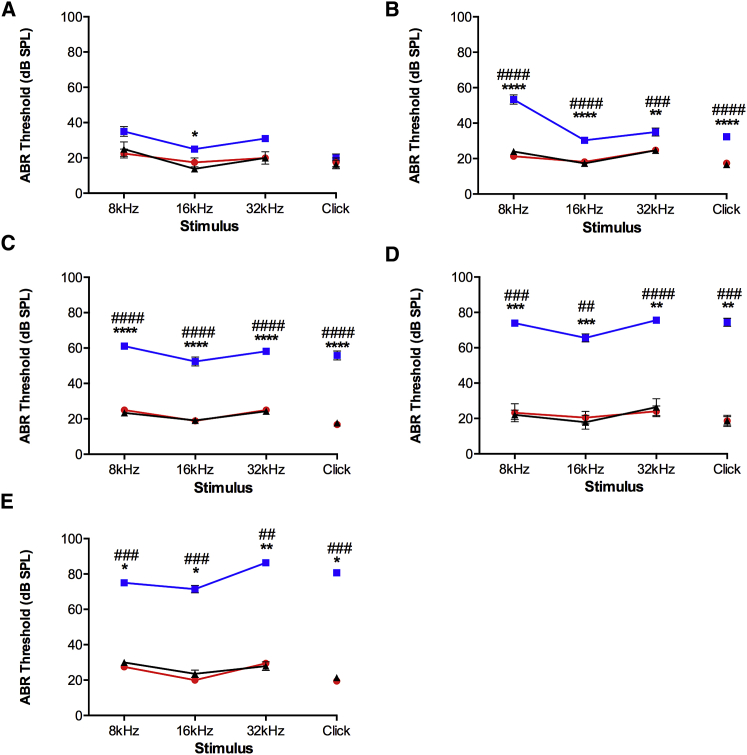
ABR PhenotypingMinimum auditory detection thresholds (decibel sound pressure level, dB SPL) were determined using auditory brainstem response (ABR) at (A) 1 month, (B) 3 months, (C) 6 months, (D) 10 months, and (E) 12 months of age. Wars2V117L/V117L, Wars2V117L/+, and Wars2+/+ littermate numbers (males and females pooled) were (A) 5, 2, and 4; (B) 15, 19, and 15; (C) 19, 19, and 22; (D) 9, 11, and 7; and (E) 7, 10, and 7, respectively; mean ± SEM. Significance was determined using a one-way ANOVA Kruskal-Wallis test with Dunn’s multiple comparisons test. Significance between Wars2V117L/V117L and Wars2+/+ and between Wars2+/V117L and Wars2+/+ is shown as ∗ and #p < 0.05, ∗∗ and ##p < 0.01, ∗∗∗ and ###p < 0.001, and ∗∗∗∗ and ####p < 0.0001, respectively. Wars2V117L/V117L mice are blue squares, Wars2V117L/+ mice are red circles, and Wars2+/+ mice are black triangles. See also Figures S1–S3 and Table S1.